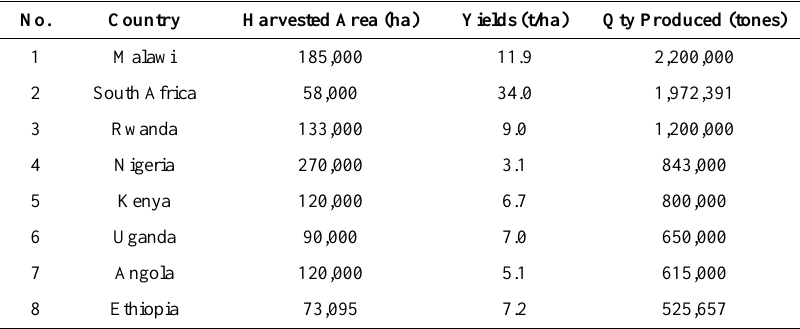
Table 1. Irish potato production yield for some Sub-Saharan African Countries No. Country Harvested Area (ha) Yields